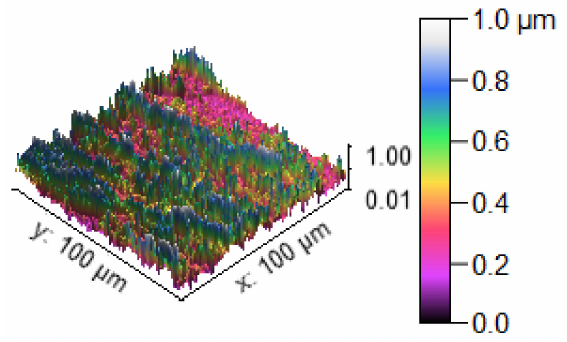
Figure 21. Three dimensional (3D) profilometric image (S-9).